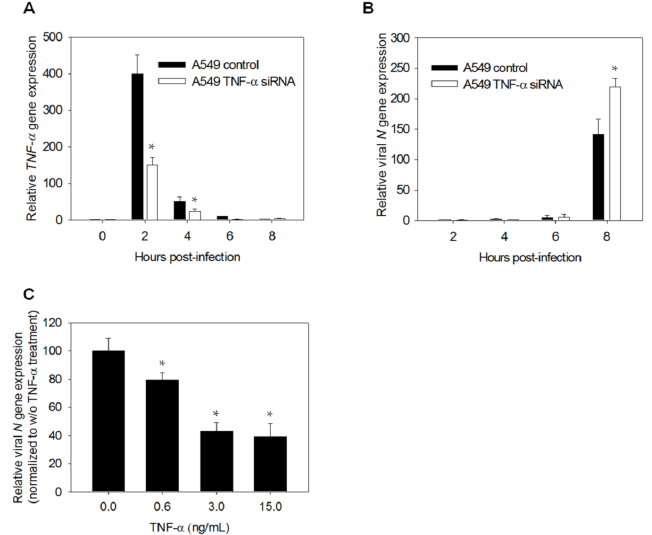
Figure 2. TNF-α inhibits viral replication in A549 cells. ( A , B ) The A549 cells were treated with control or TNF-α siRNA for 24 h and challenged with HCoV 229E of 0.1 MOI. Total RNA was harvested at indicated time and analyzed for TNF- α mRNA and viral N gene expression; ( C ) The A549 cells were challenged with different concentration of TNF-á for 24 h then infected with HCoV 229E of 0.1 MOI for 8 h. Total RNA was harvested for analyzing viral N gene expression by quantitative-PCR. Values represent average ± SD of three measurements. * p < 0.05, as compared to control siRNA-treated cells.